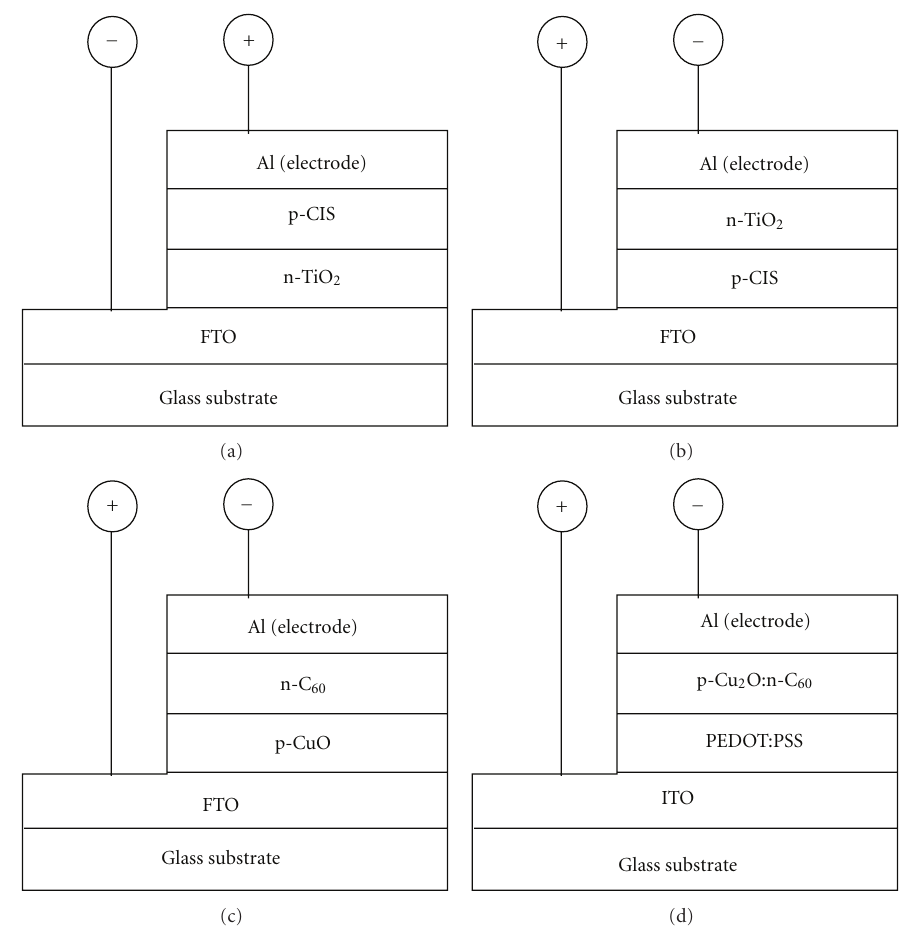
Figure 1: Structures of (a) FTO/TiO 2 /CIS/Al, (b) FTO/CIS/TiO 2 /Al, (c) FTO/CuO/C 60 /Al heterojunction solar cells, and (d) ITO/PEDOT:PSS/Cu 2 O:C 60 /Al bulk heterojunction solar